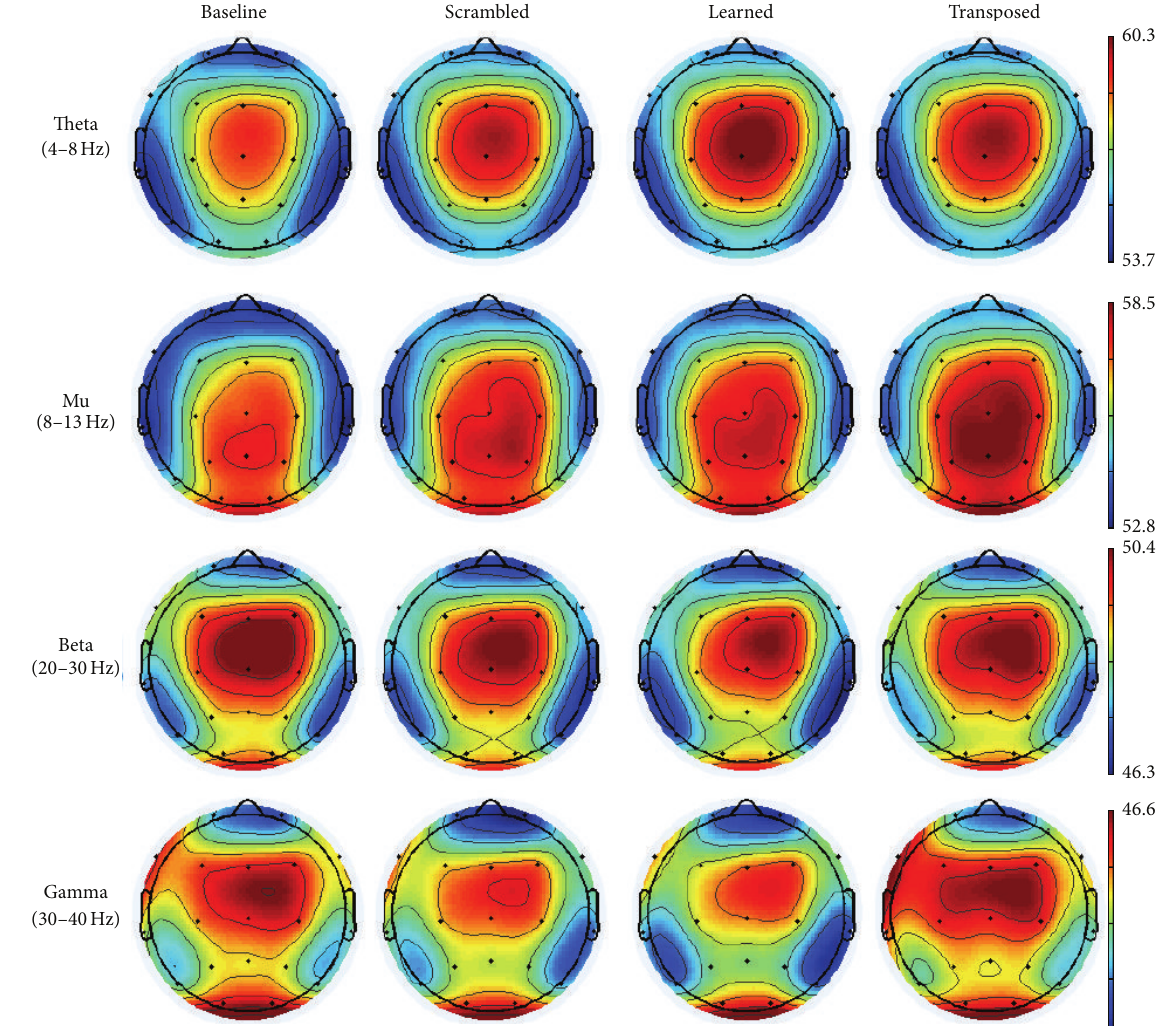
Figure 6: Scalp distribution of different frequency band activities. Units for power heat maps are microvolts